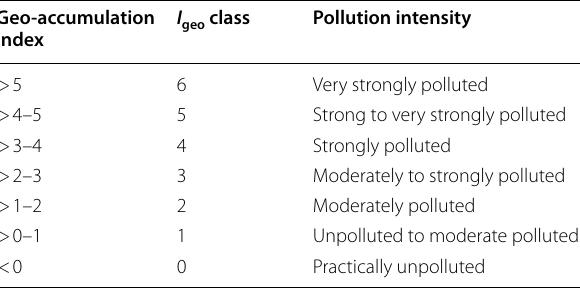
Table 4 Classification of geo-accumulation